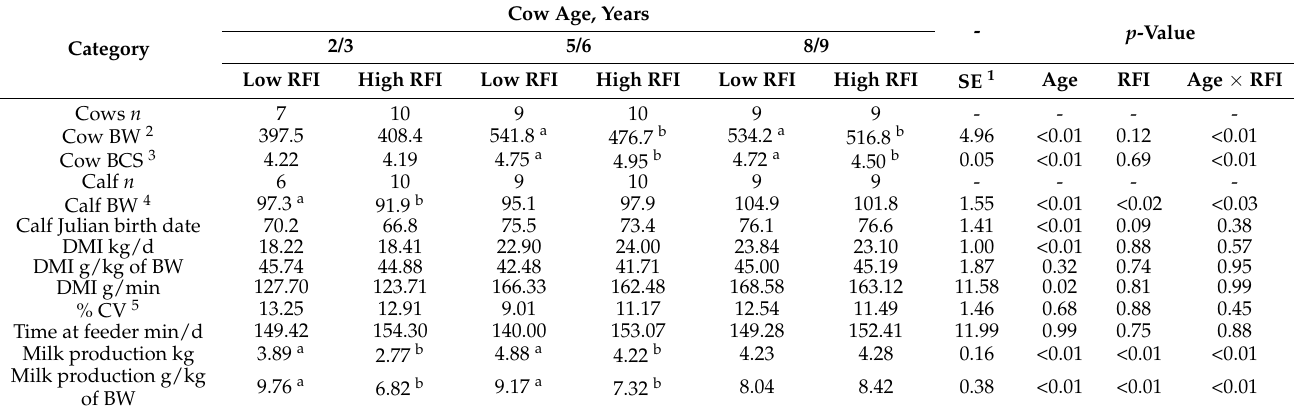
Table 3. The influence of heifer post-weaning RFI on subsequent beef cow performance and dry matter intake behavior of 3 age classes of lactating, non-pregnant beef cows average 60-d post-partum (Study 2).